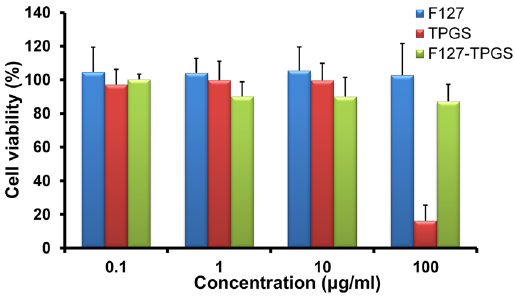
Figure 5. Viability of BCECs cells after 60 h treatment with varying concentrations of excipients (Pluronic F127, TPGS and FT mixed micelles). Data represent means ± SD (n = 6).